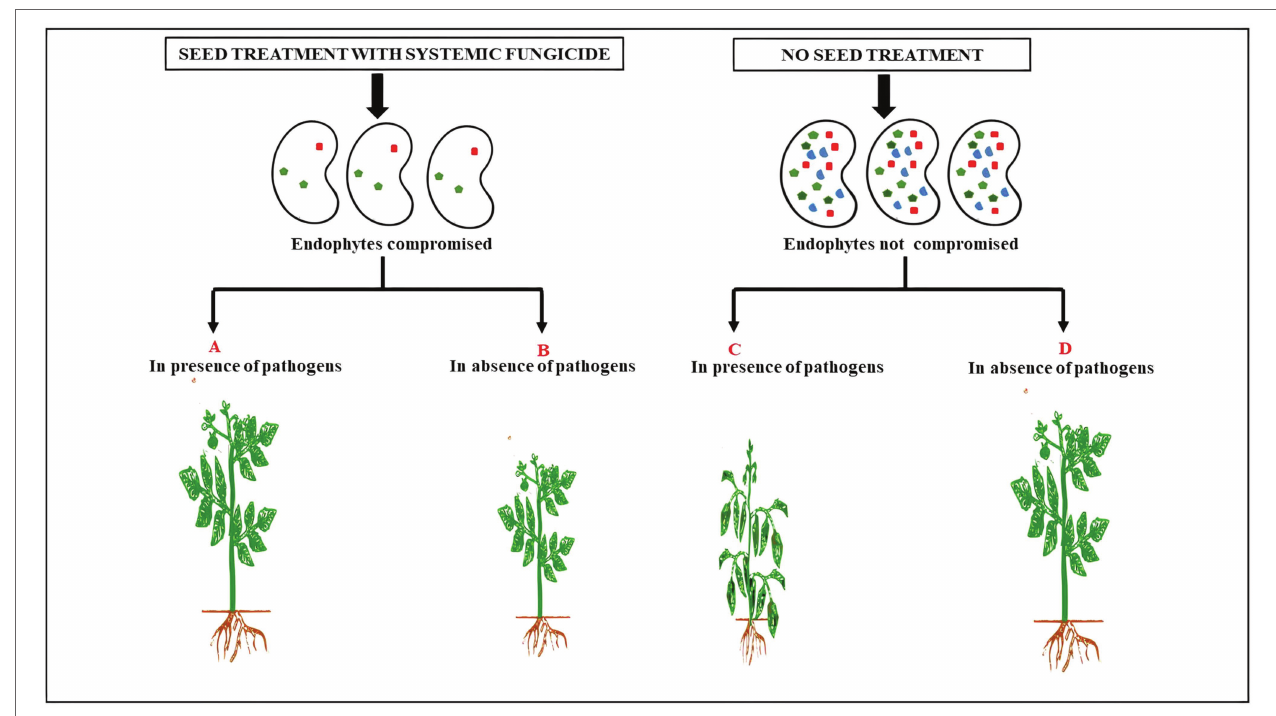
FIGURE 1 | The effect of seed treatment with systemic fungicide on plant growth in presence or absence of seed- and soil-borne pathogens. The decrease in plant growth (B) represents the loss of endophyte-mediated growth promotion in seeds treated with systemic fungicide in the absence of seed- and soil-borne pathogens. This has to be contrasted with the phenotype of plant in (D) . The difference in growth between (B) and (D) can be attributed to the beneficial effects of endophytes which are lost due to seed treatment with systemic fungicides. (A,C) refers to plants subjected to soil and seed borne pathogens but either treated (A) or untreated (C) with